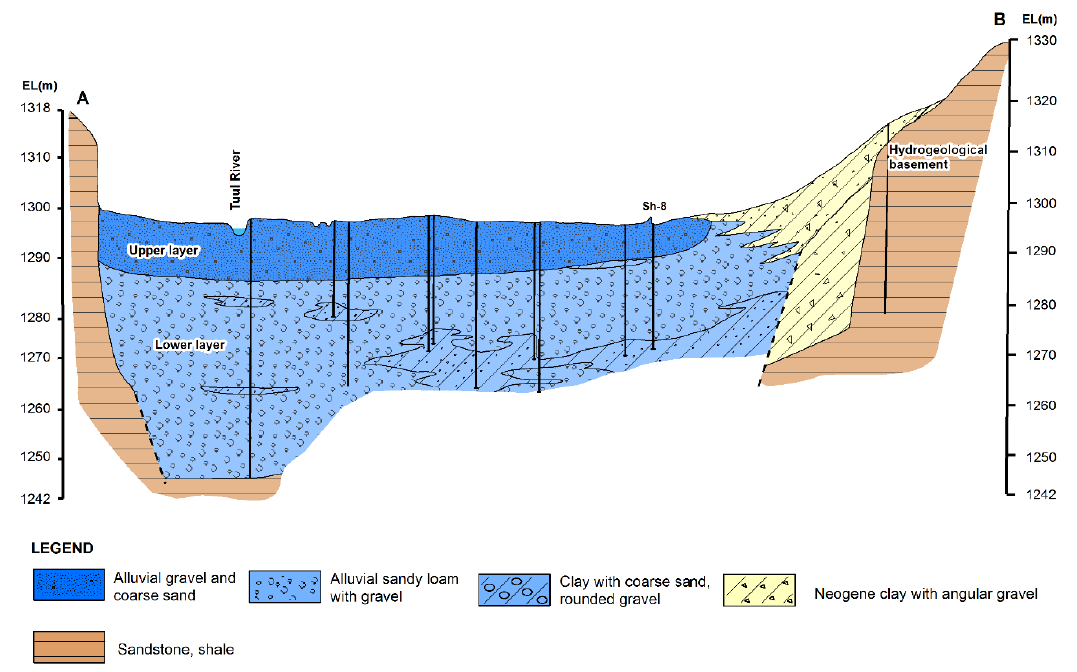
Figure 2. Hydrogeological cross-section of the alluvial aquifer around Ulaanbaatar (modified from [24]).